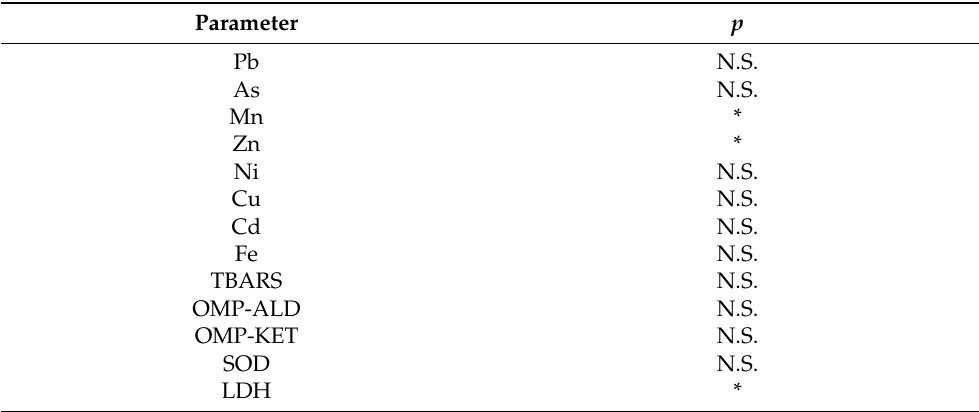
Table 6. Correlations between oxidative stress indicators and trace elements accumulation with the leukocytes count (N.S.—not significant; * p <